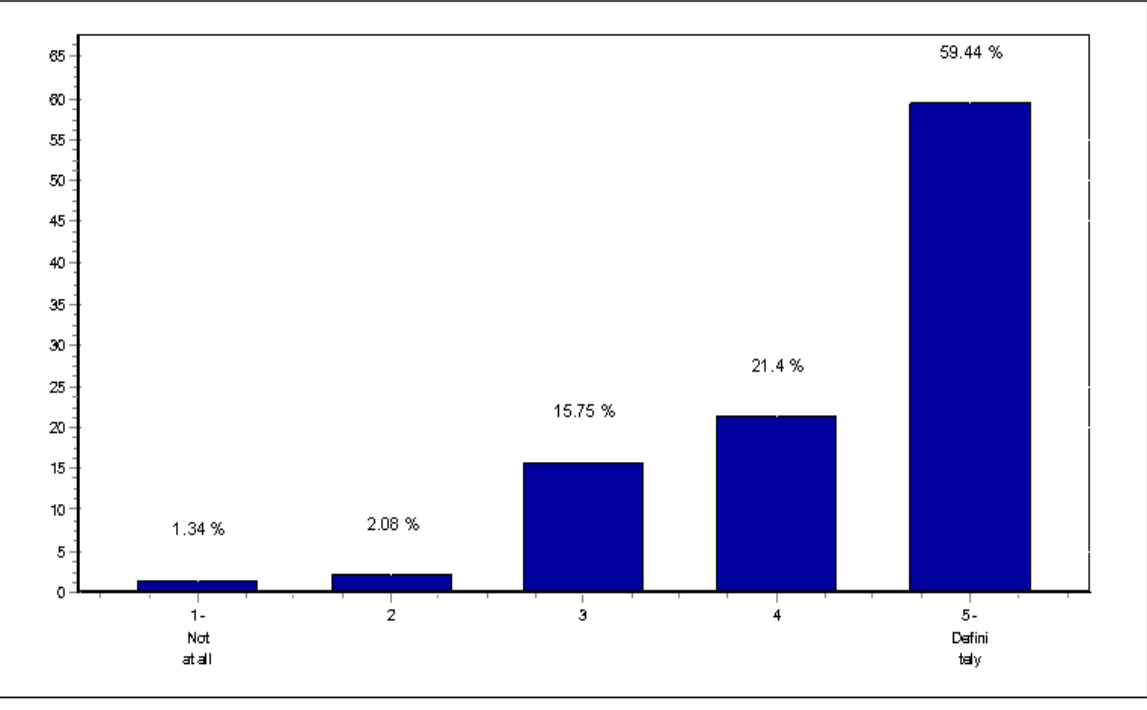
Fig. 3. More inclined or interested in starting your own